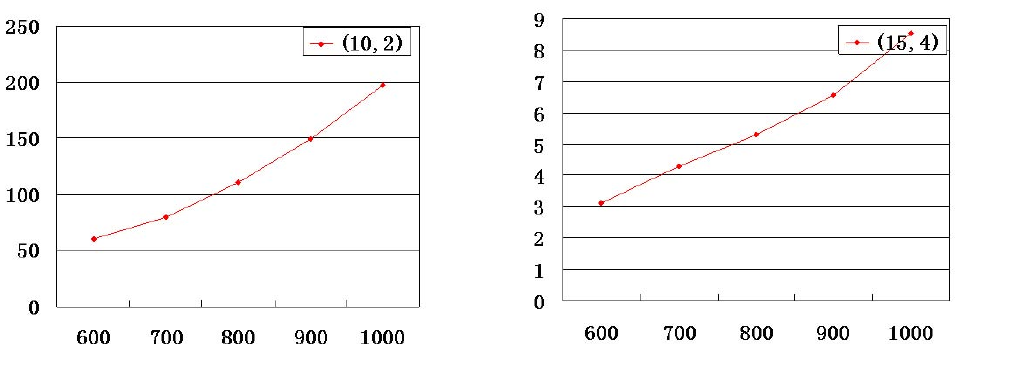
Figure 3: The influence of parameter L on